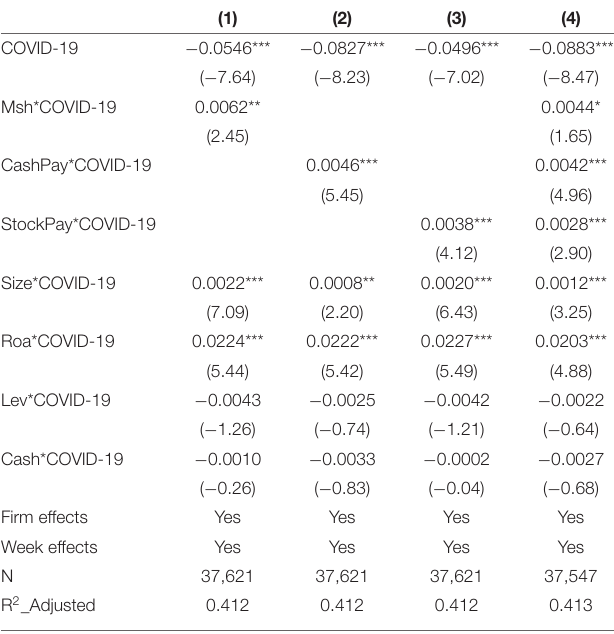
TABLE 4 | Managerial compensation and stock returns in response to